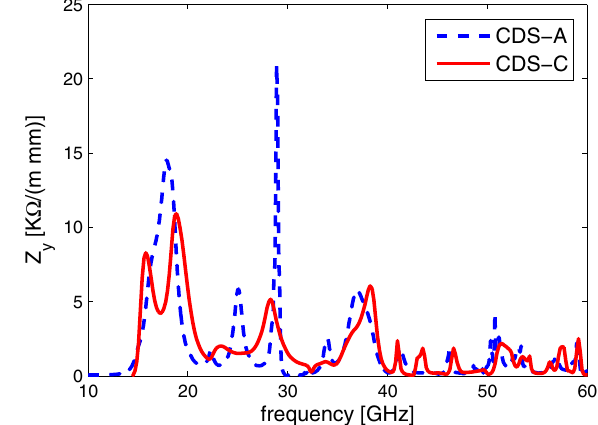
FIG. 16. Wakefield impedance spectrum of CDS-C compared with CDS-A.